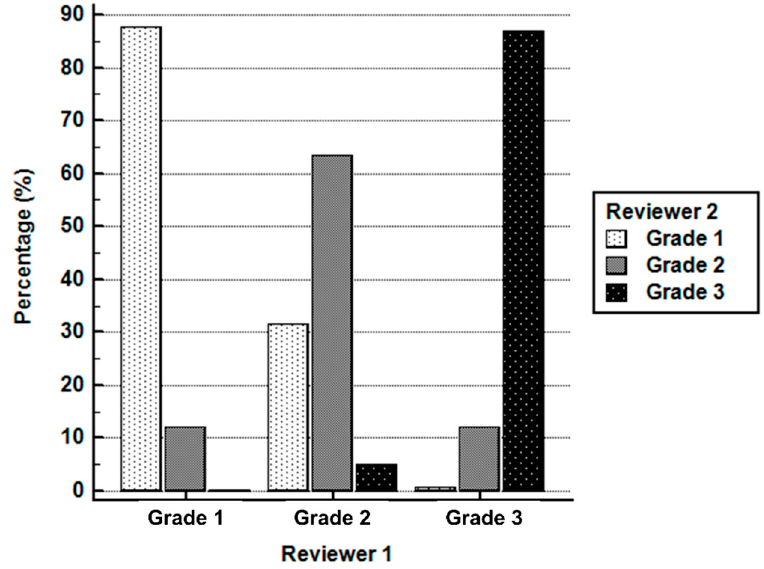
Figure 2. Inter-rater agreement in the grading joints on bone scintigraphy between two readers.